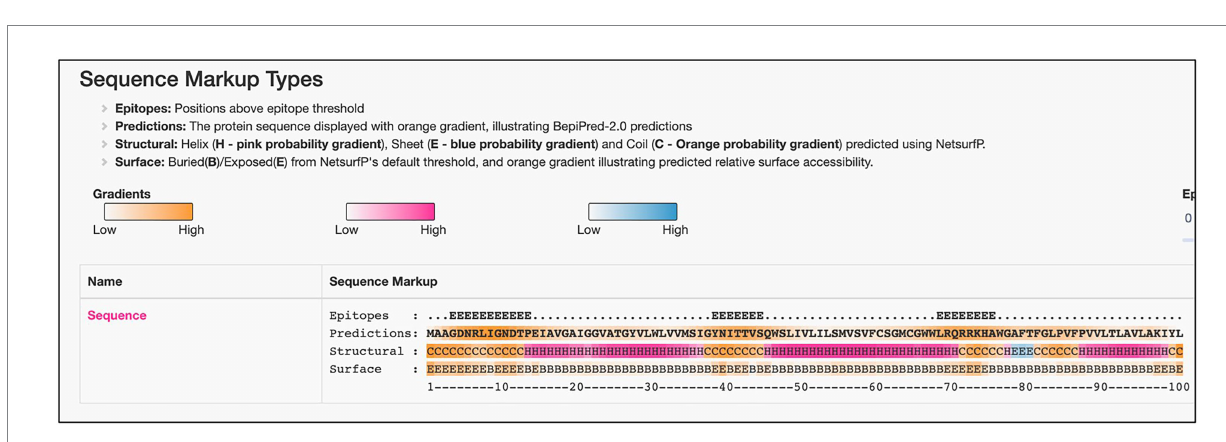
FIGURE 7 Predicted linear B-Cell epitopes in the possible membrane